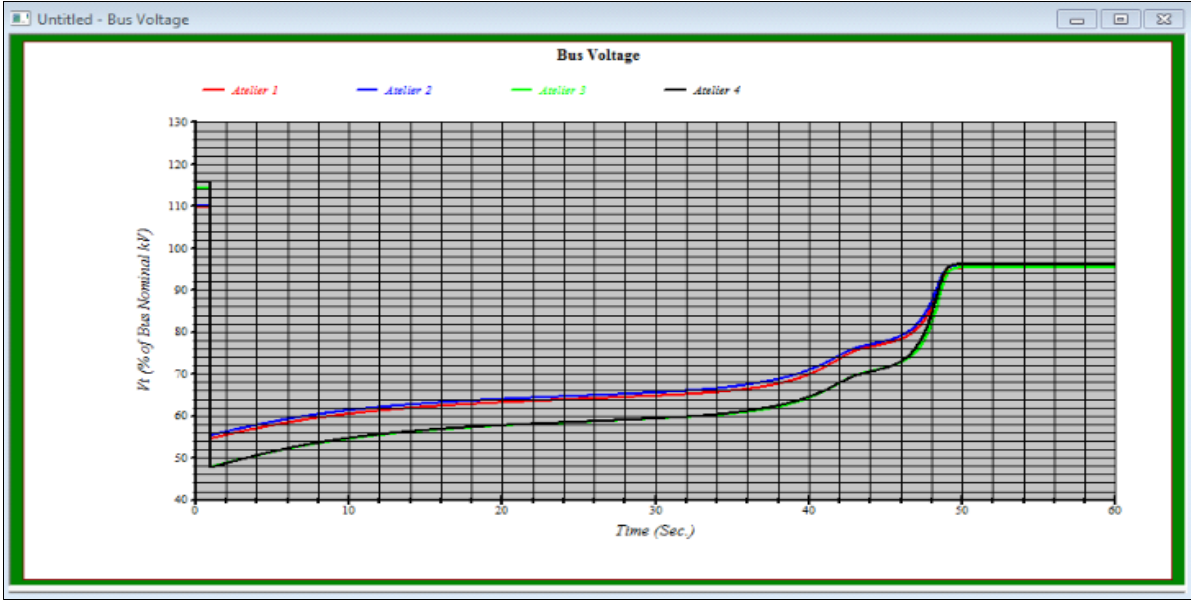
Figure 7: The starting voltage of the motors as a function of time after the insertion of the capacitor banks. Source: Authors,